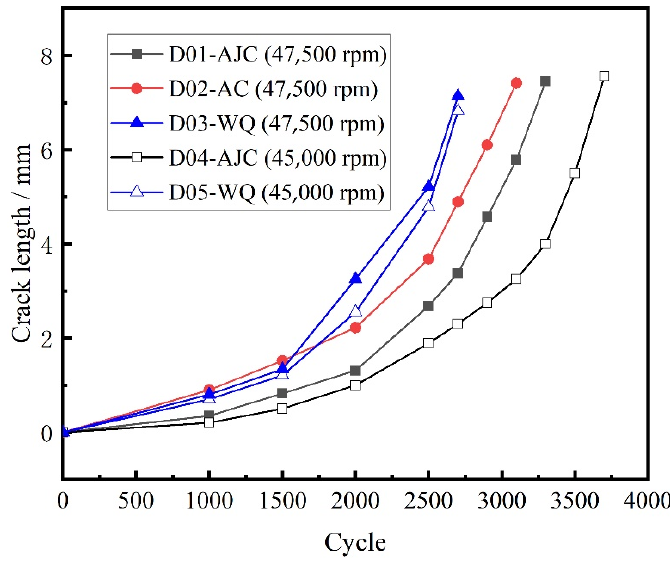
Figure 16. External surface crack length recorded using the surface replica method.